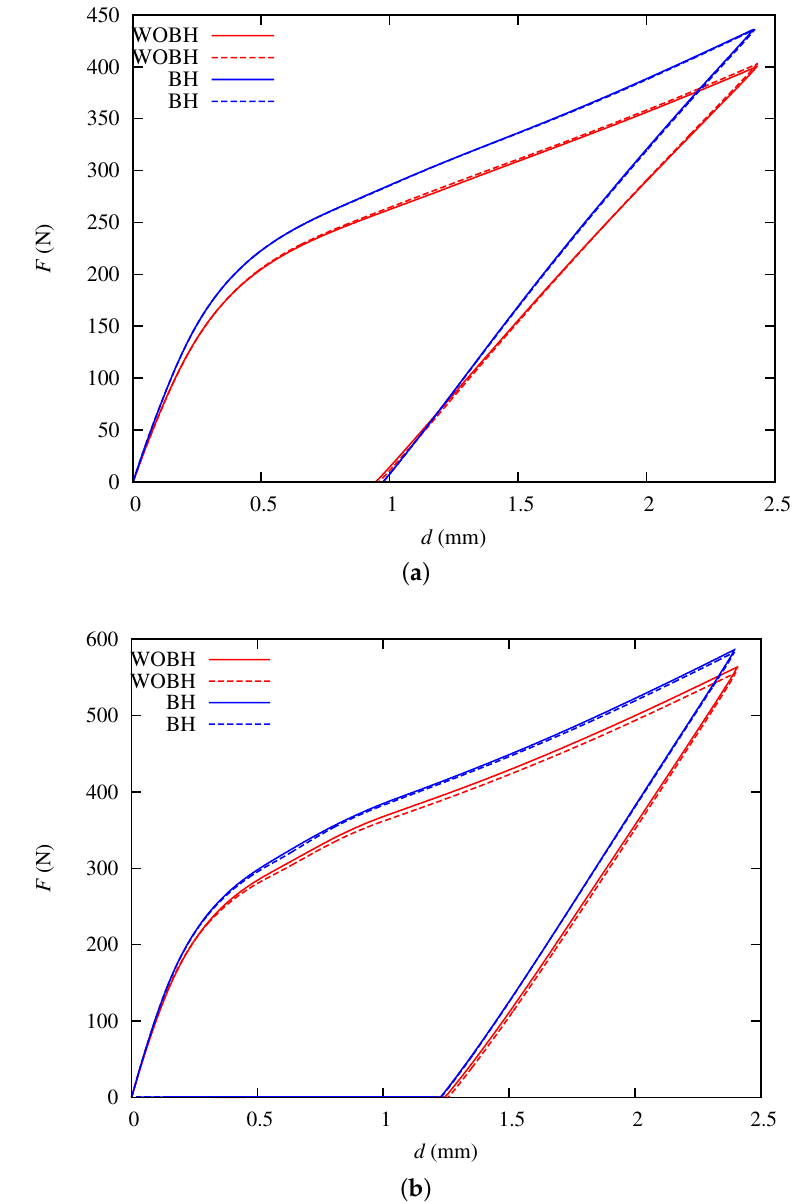
Figure 8. Load versus corrected displacement ( d ) during dent test with (BH) or without bake hardening (WOBH), after a pre-strain in hydraulic bulging. Continuous and dashed lines represent two tests having the same pre-strain magnitude. ( a ) Pre-strain (cid:101) xx ≈ 0.02; ( b ) Pre-strain (cid:101) xx ≈